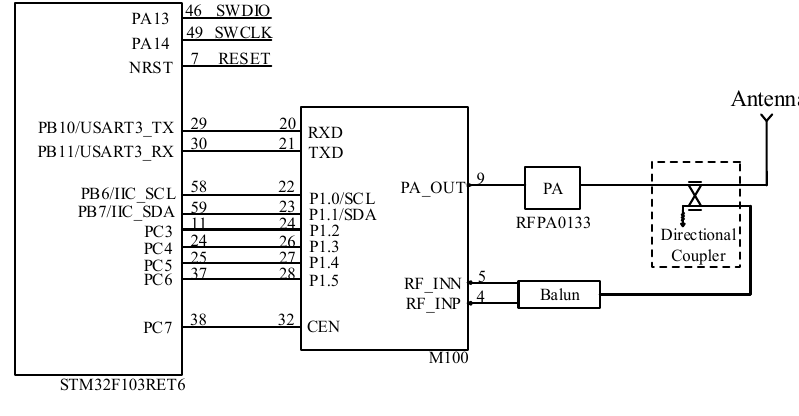
Figure 4. RF interface circuit.